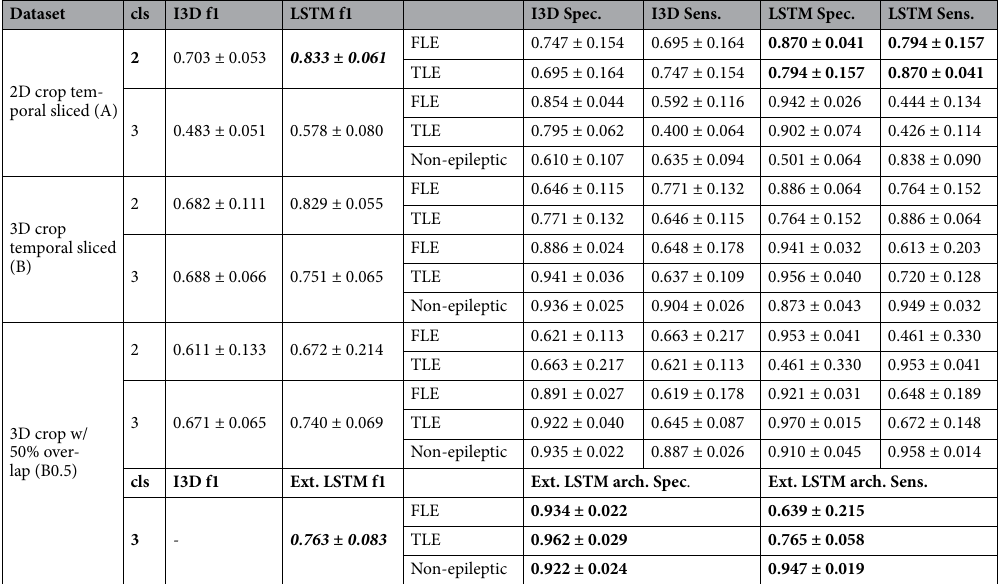
Table 2. 5-fold cross validation F1 scores, sensitivity (Sens.) and specificity (Spec.) results for all 3 datasets and designed architectures, ( cls number of classes, ext. LSTM extended LSTM archtiecture). Best results are in bold.